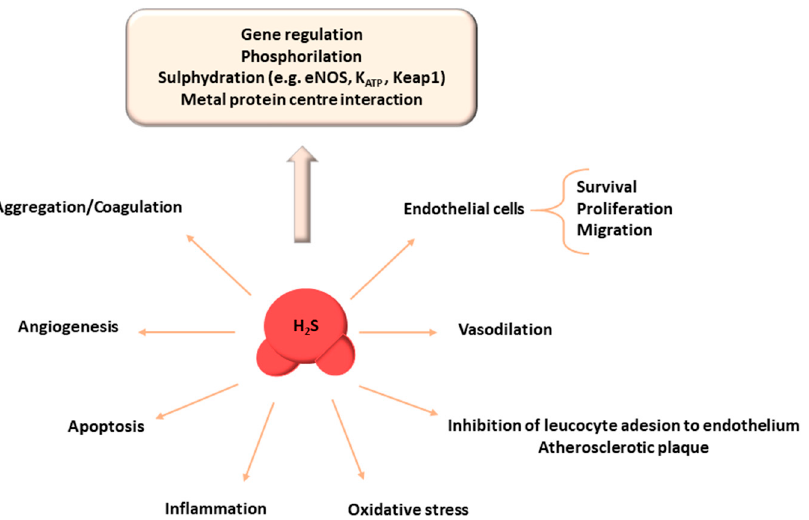
Figure 1. Main molecular, cellular, and systemic actions of hydrogen sulfide. H 2 S attenuates apoptosis and decreases oxidative stress by a direct action, upregulating the cellular antioxidant system. H 2 S also produces an anti-inflammatory response through the inhibition or induction of specific pathways. At the vascular level, in addition to promoting cell proliferation and migration, it induces angiogenesis, vasodilation, represses aggregation and coagulation, and reduces aortic atherosclerotic plaque formation. The mechanisms underlying the effects of H 2 S include the phosphorylation and addition of cysteine residues to target proteins, interaction with the metal protein centers of proteins, and gene regulation (for more details see text). Abbreviations: eNOS: endothelial nitric oxide synthase; H 2 S: hydrogen sulfide; K ATP : ATP-sensitive potassium channels; Keap1: Kelch-like ECH-associating protein 1.